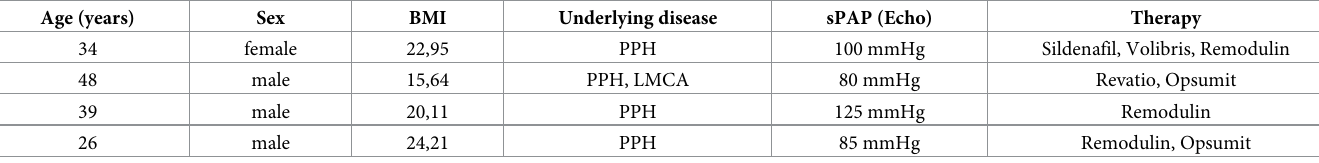
Table 1. PAH patient